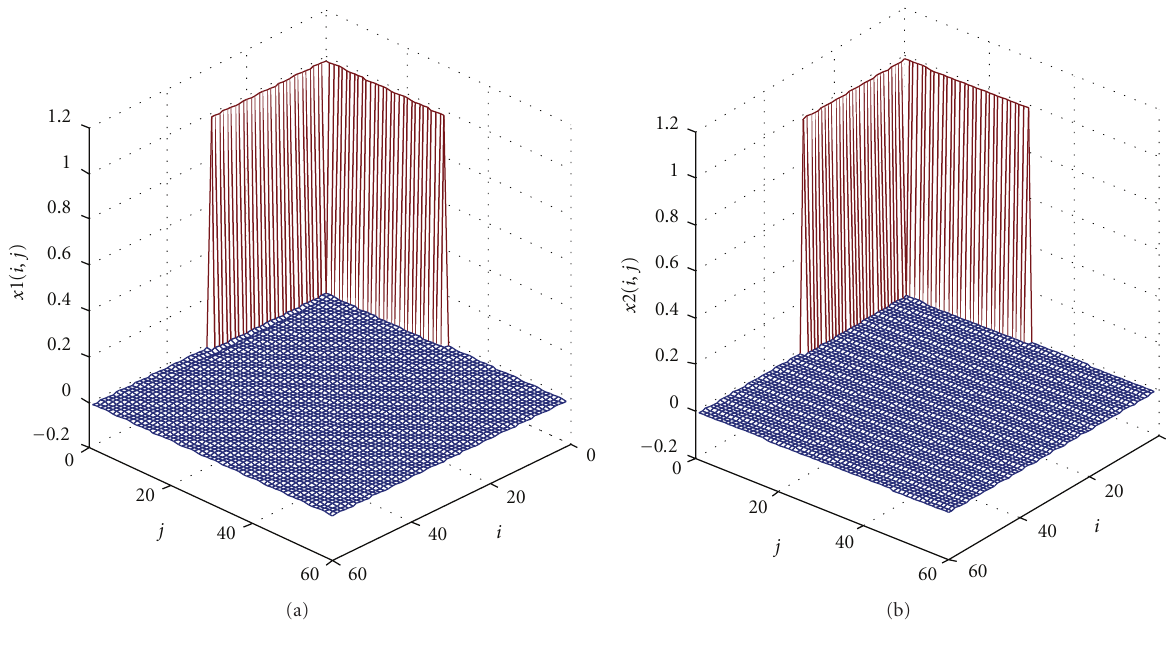
Figure 1: Trajectories of the two state variables (Example